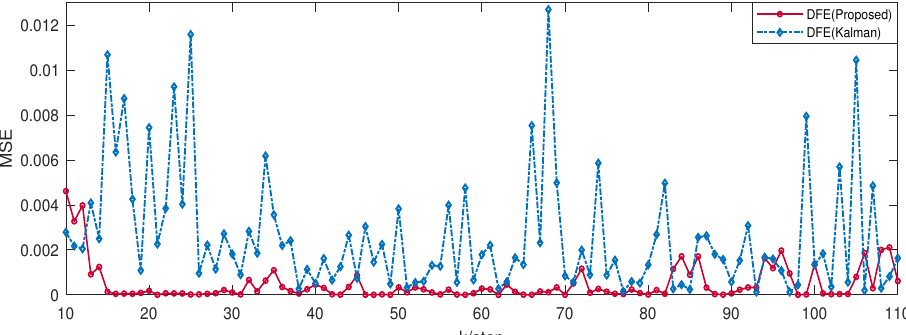
Figure 6. The performance comparison between the intermediate-variable-based fusion estimator and Kalman fusion